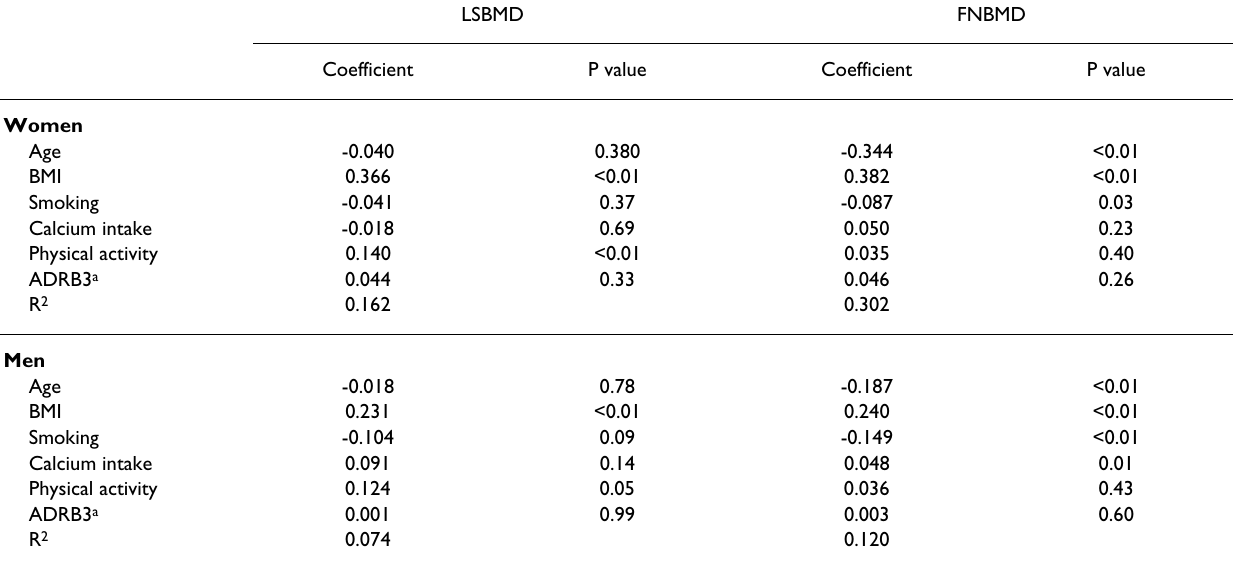
Table 2: ADRB3 genotype and BMD: Standardized regression coefficient from the multiple regression analyses LSBMD FNBMD Coefficient P value Coefficient